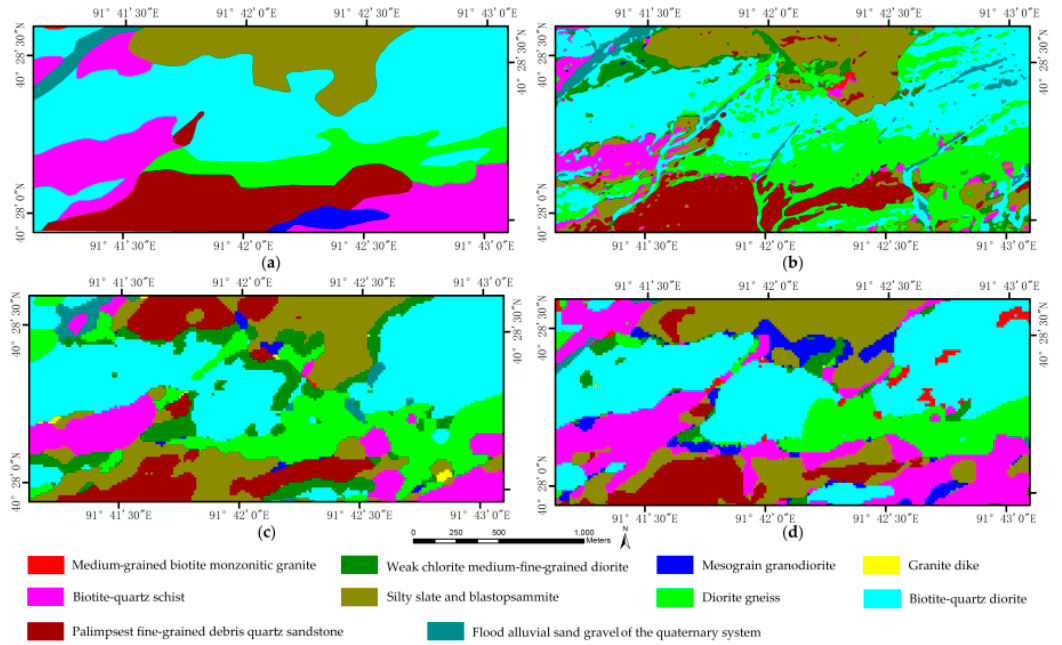
Figure 8. Lithological classification maps in the southeast corner of the research area. ( a ) Lithological map by visual interpretation; ( b ) lithological classification map of WV-3 data; ( c ) lithological classification map of ASTER data; and ( d ) lithological classification map of OLI/Landsat data. Biotite–quartz schist was not recognized in the WV-3 data.